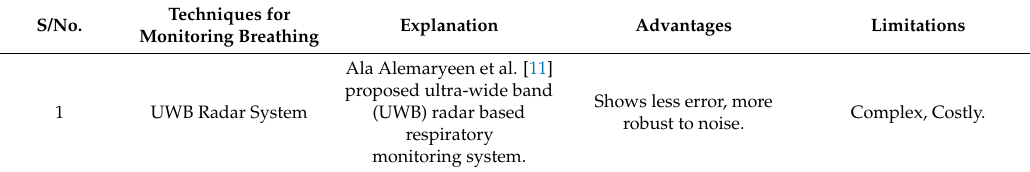
Table 1. Comparison between different techniques for monitoring